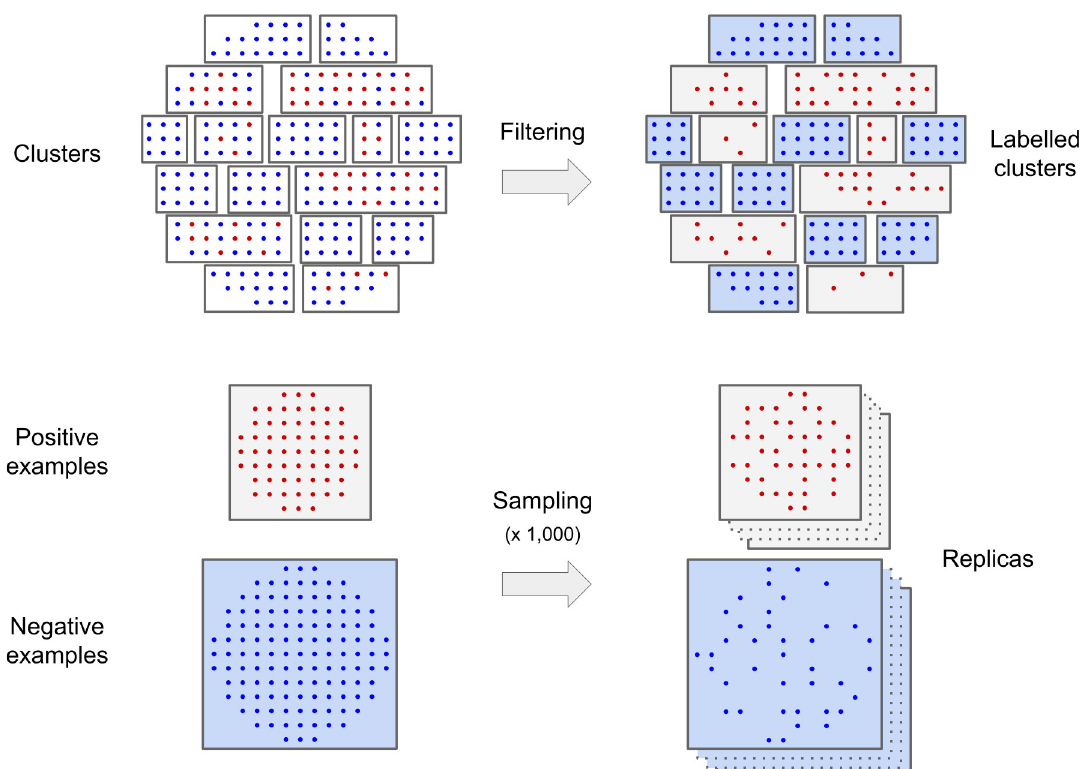
Fig 6. Dataset generation. Negative (blue dots) and positive sites (red dots) are clustered based on sequence similarity. Positive clusters (gray background) contain at least one hydroxylation site and negative examples falling inside positive clusters are removed. 1,000 replica sets are created by random sampling 70% of the positive sites and the same number from the